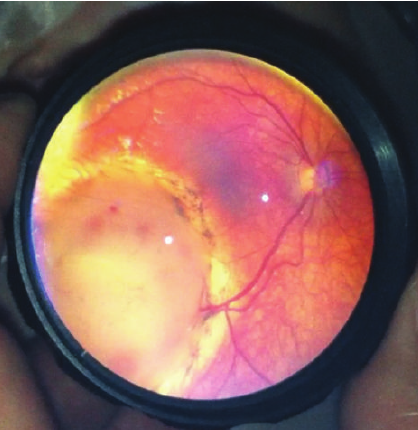
Figure 5: Vasculitis imaged in emergency department setting.